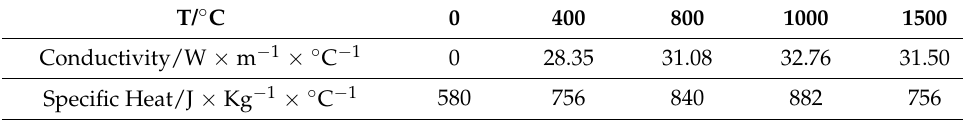
Figure 7. Changes of thermophysical property parameters of Ni-based alloys with temperature. Table 4. The thermophysical property parameters of the 40 Cr steel.